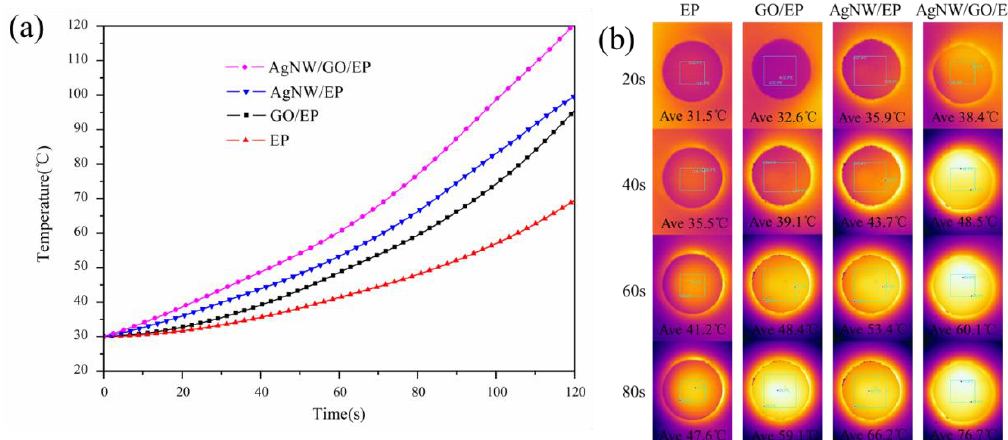
Figure 8. ( a ) Surface temperature variation with heating time and ( b ) infrared thermal images of EP, GO/EP, AgNW/EP, and AgNW/GO/EP composites.